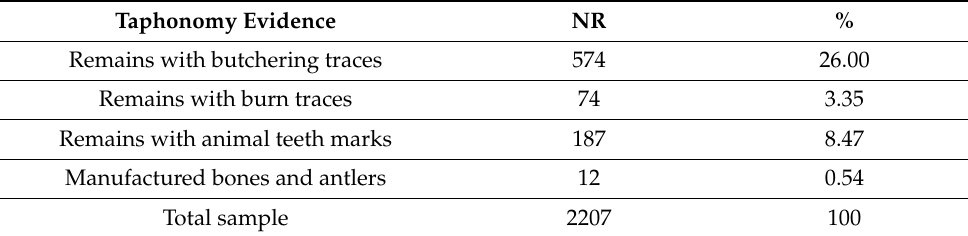
Table 2. Halmyris, Romania, 2014, extramuros area (4th–6th centuries AD). Distribution of remains with taphonomy evidence (NR = number of